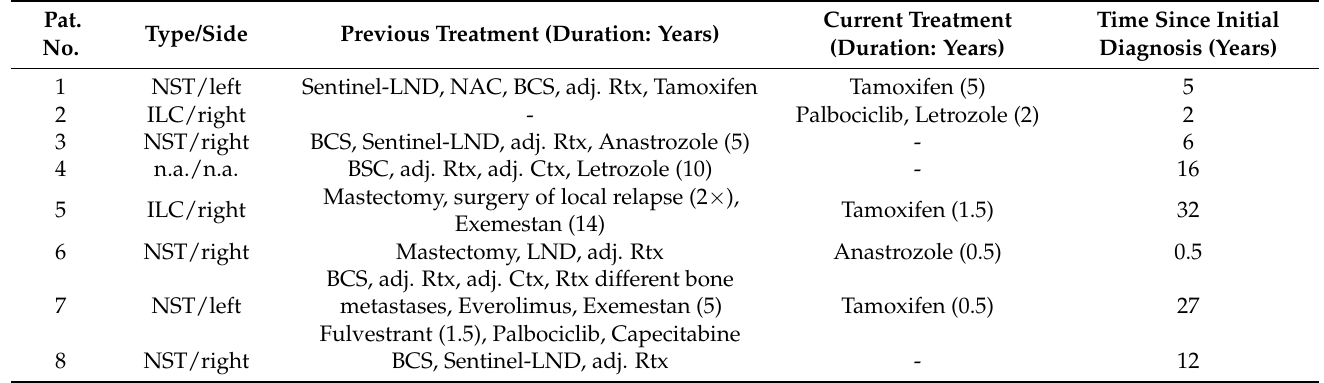
Table 1. Patient characteristics.